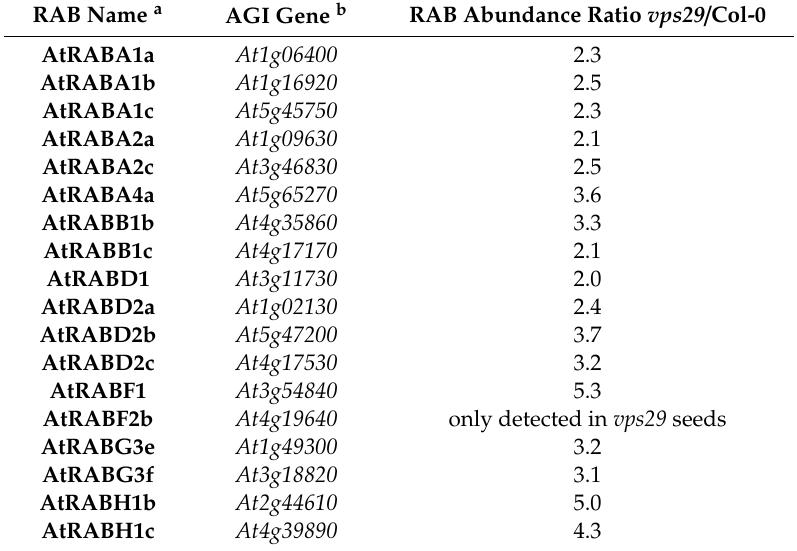
Table 3. Proteins of the RAB GTPase family found to be more abundant in vps29